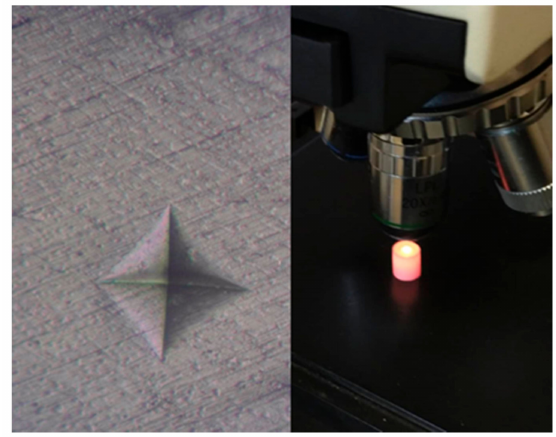
Figure 3. Vickers microhardness test.